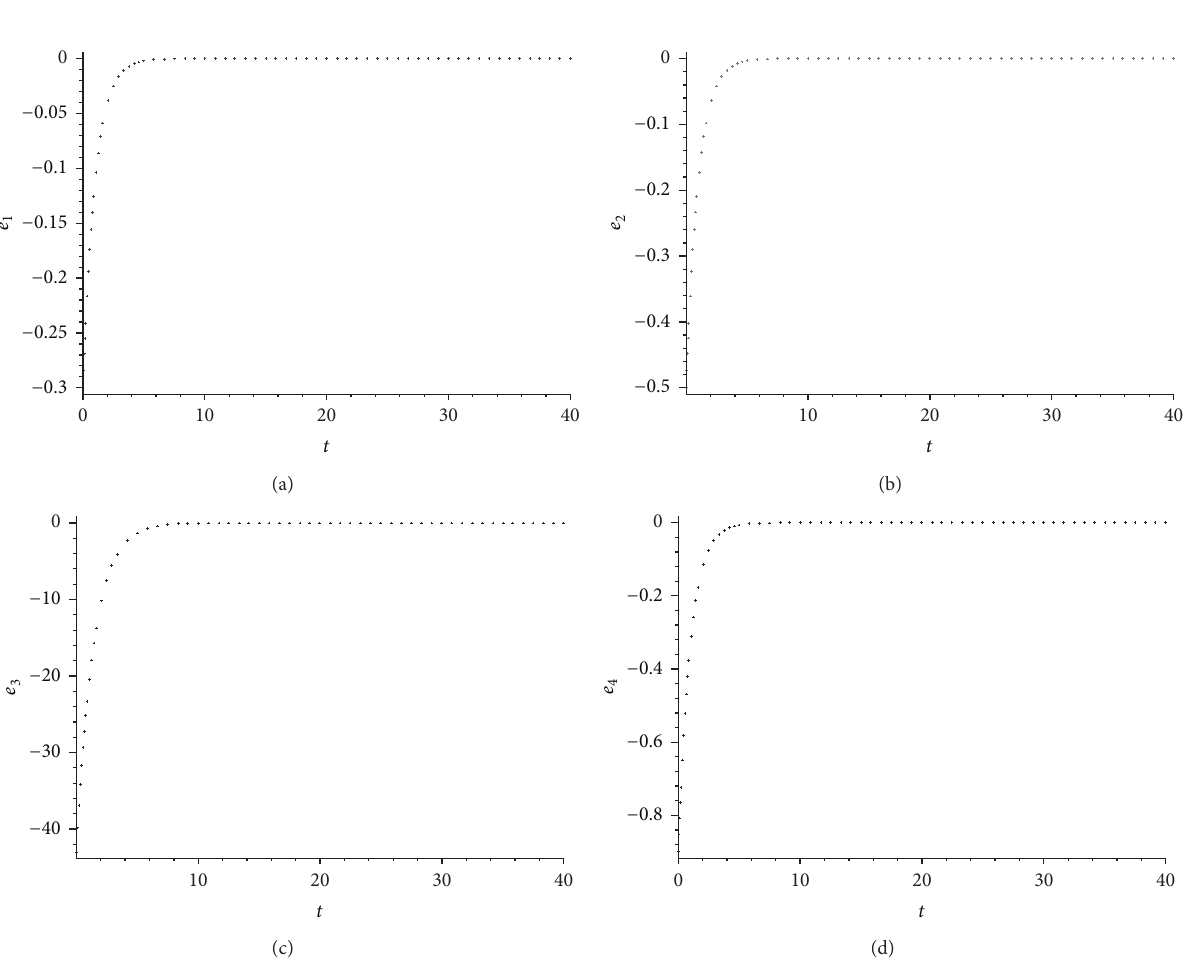
Figure 12: The dynamics of synchronization errors. (a) Signal 𝑒 1 , (b) signal 𝑒 2 , (c) signal 𝑒 3 , and (d) signal 𝑒 4